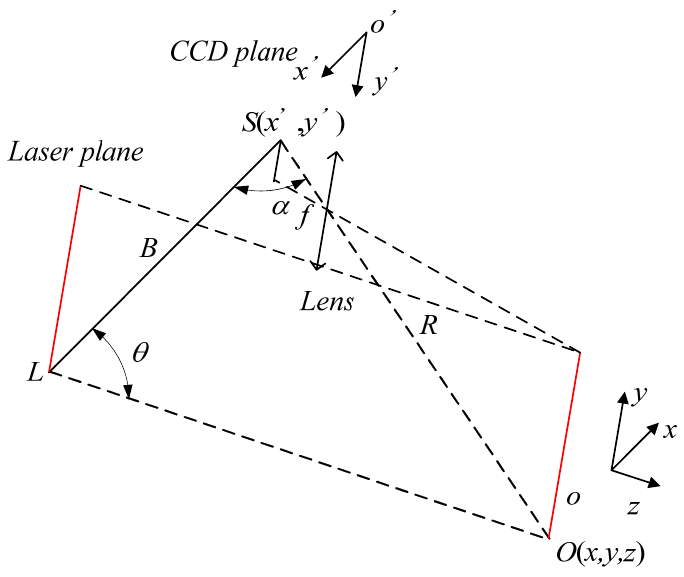
Figure 2. CCD geometry imaging